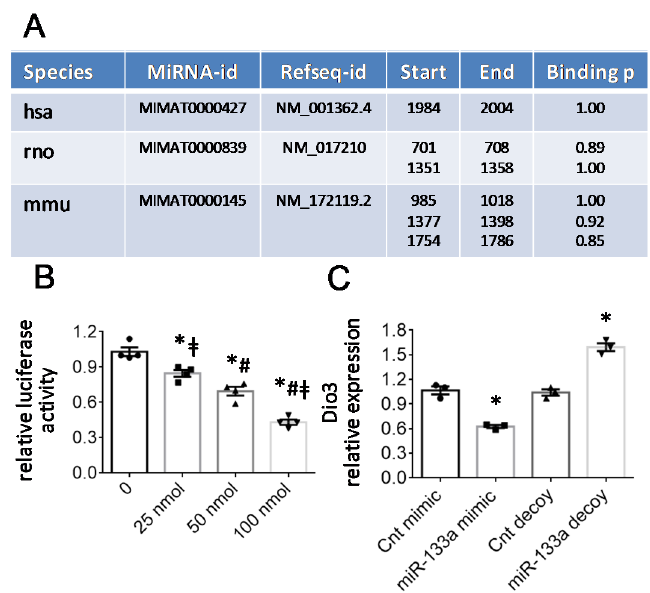
Figure 6. Dio3 transcript is a direct target of the T3-sensitive miR-133a. ( A ) Predicted pairing between the 3 (cid:48) UTR of the human, rat, and mouse Dio3 and the seed sequence of the conserved miR-133a-3p as reported by the miRWalk and/or TargetScan predictive algorithms. ( B ) The entire mmu 3 (cid:48) UTR of Dio3 has been cloned in a reporter vector downstream of the luciferase gene and transfected in neonatal rat cardiomyocytes. The co-transfection with miR-133a reduced luciferase activity in a dose-dependent manner. n = 4, * p ≤ 0.004 vs. Cnt; # p ≤ 0.01 vs. 25 nM; ‡ p ≤ 0.01 vs. 50 nM. ( C ) Relative expression of Dio3 in cultured neonatal cardiomyocytes 48 h after transfection with miR-133a mimic or miR-133 decoy. n = 3, * p ≤ 0.007 vs. respective Cnt.